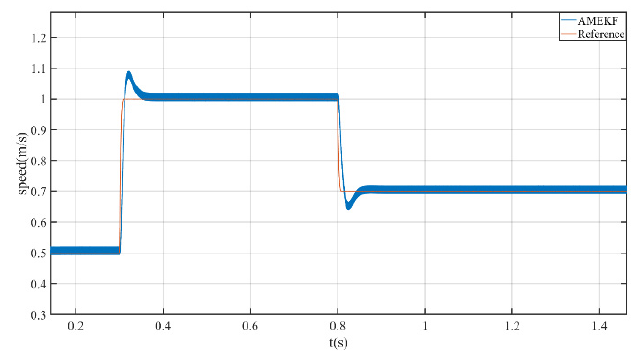
Figure 12. Actual speed and estimated speed under EKF algorithm .